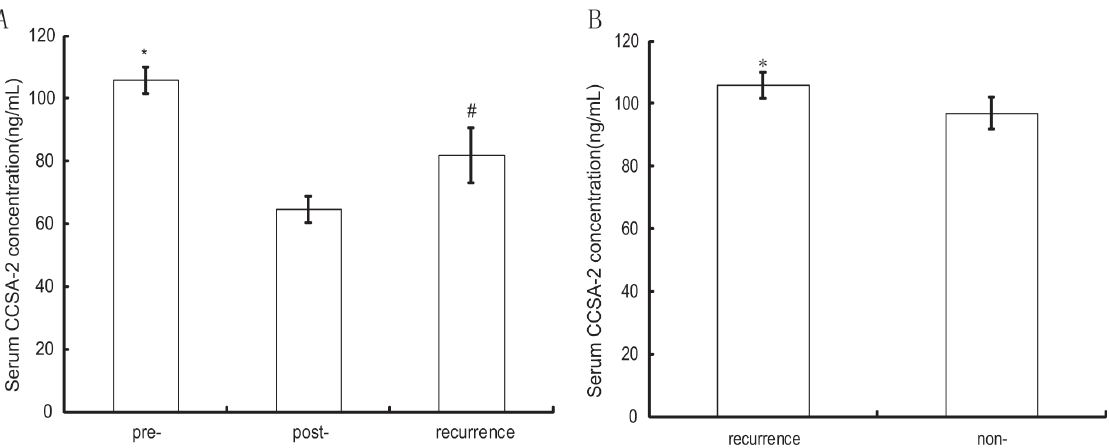
Figure 3. The use of serum CCSA-2 as a surveillance and prognostic marker for CRC. (A) Serum CCSA-2 levels in pre-operation, post- operation and after recurrences in patients who suffered relapse during the follow-up period. *:the serum CCSA-2 concentration in pre-operation was significantly higher than each of the other individual groups ( P , 0.01); # : the serum CCSA-2 levels after recurrences was higher than that in post- operation ( P , 0.01). (B) Comparison of pre-operative serum CCSA-2 levels in patients with recurrences and without recurrences during the follow-up period after surgery. *: Statistic analysis showed the pre-operative serum CCSA-2 concentration in patients with recurrences was significantly higher than those in patients without recurrences after surgery ( t =6.18, P , 0.001).